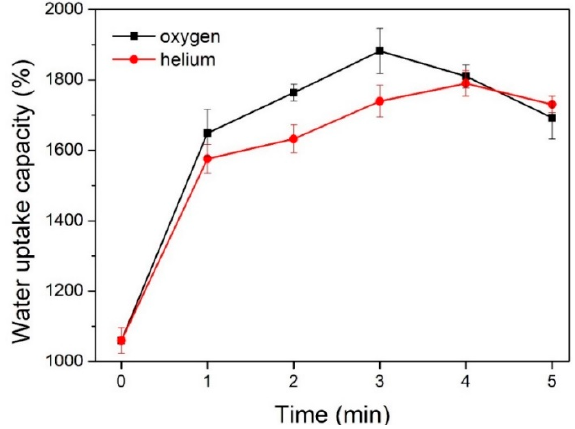
Figure 8. Water uptake capacity before and after plasma treatments.